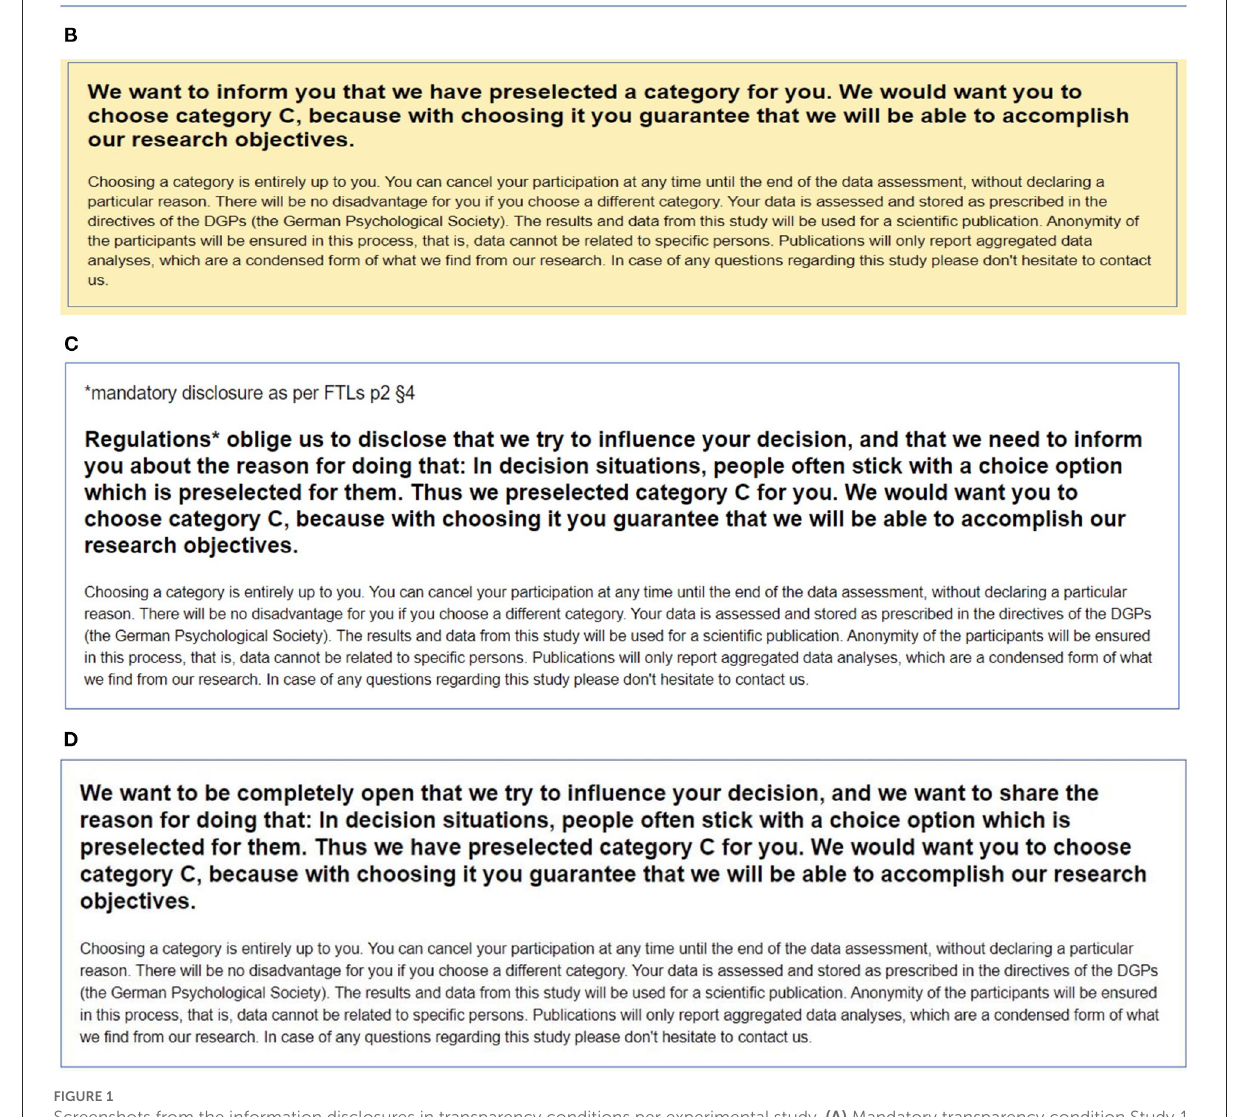
Study 1 (71%) and Study 2 (56%), participants selected the defaulted option above chance levels (20%), with both p < 0.001. Hence, we report a significant main effect